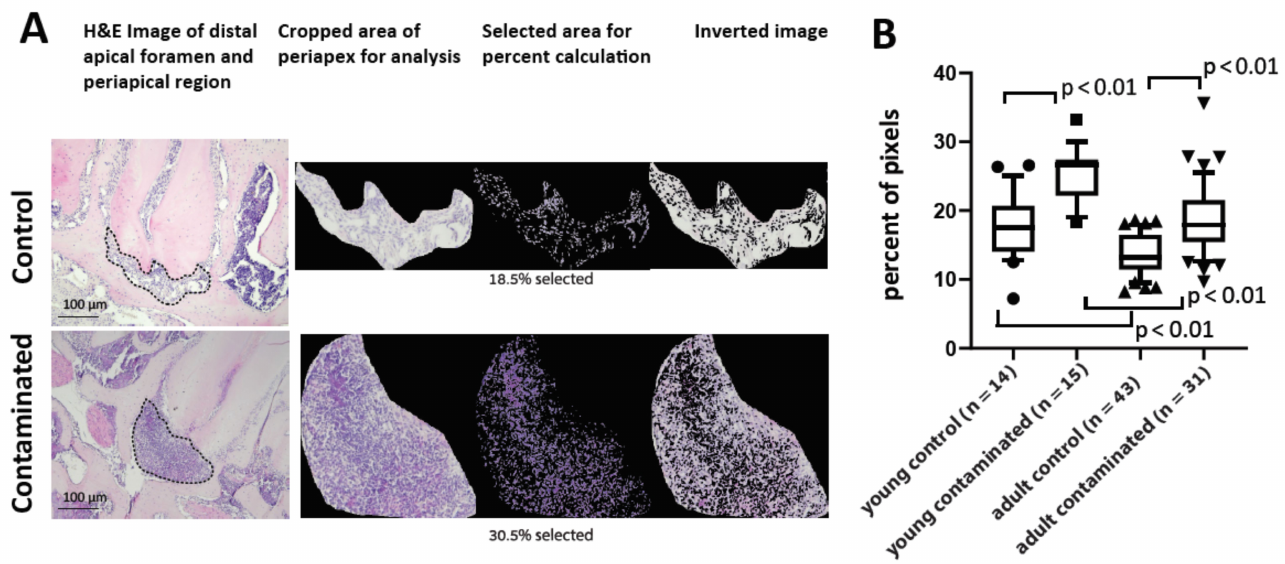
Figure 3. Computerized analysis of periapical cell density. We developed a computerized test to quantify the percentage of nuclei in the PA region to evaluate the cell density. ( A ) Representative images of the analysis method. (Left) representative images of a control tooth (with normal PDL region in the apex), and a contaminated tooth (with an immune cell infiltrate in the apical region). The dashed line delimits the cropped area of the periapical region for analysis. (Right) 3 images from the computer’s output (from left to right): the cropped area, the cell nuclei selected for quantification, and the inverted image, indicating that, indeed, all the cells were included in the analysis. The percentage of the image stained (representing the number of nuclei, indicating cell density) is presented for each tooth. ( B ) Quantification of cell density. The Y axis shows the percentage of pixels (from the computer output), which represents cell density. The cell density of the control and contaminated groups of both young and adult mice are presented. n (number of canals): young control = 21, young contaminated = 15, adult control = 43, adult contaminated =